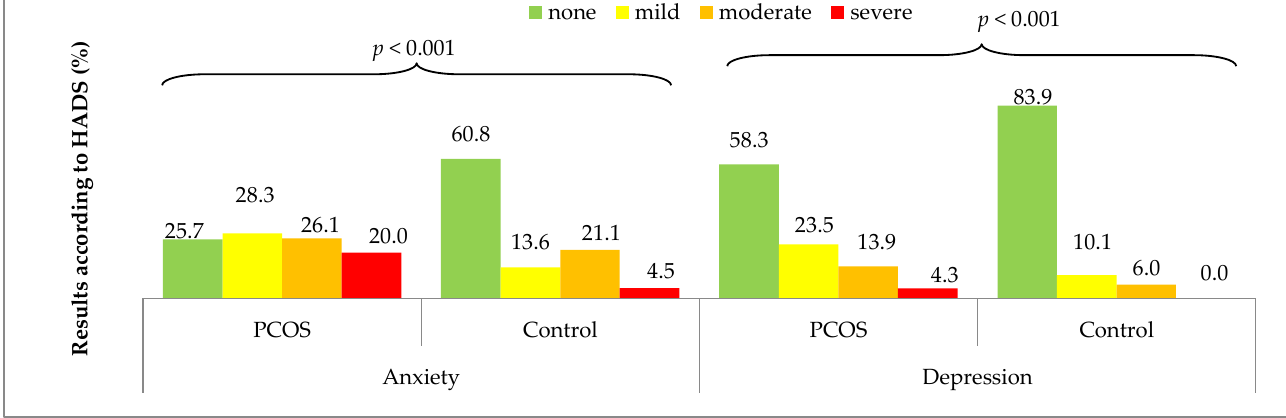
Figure 2. Severity of anxiety and depression symptoms acc. to HADS in the PCOS group and control group. Results are presented as n (%). p for chi-square test.